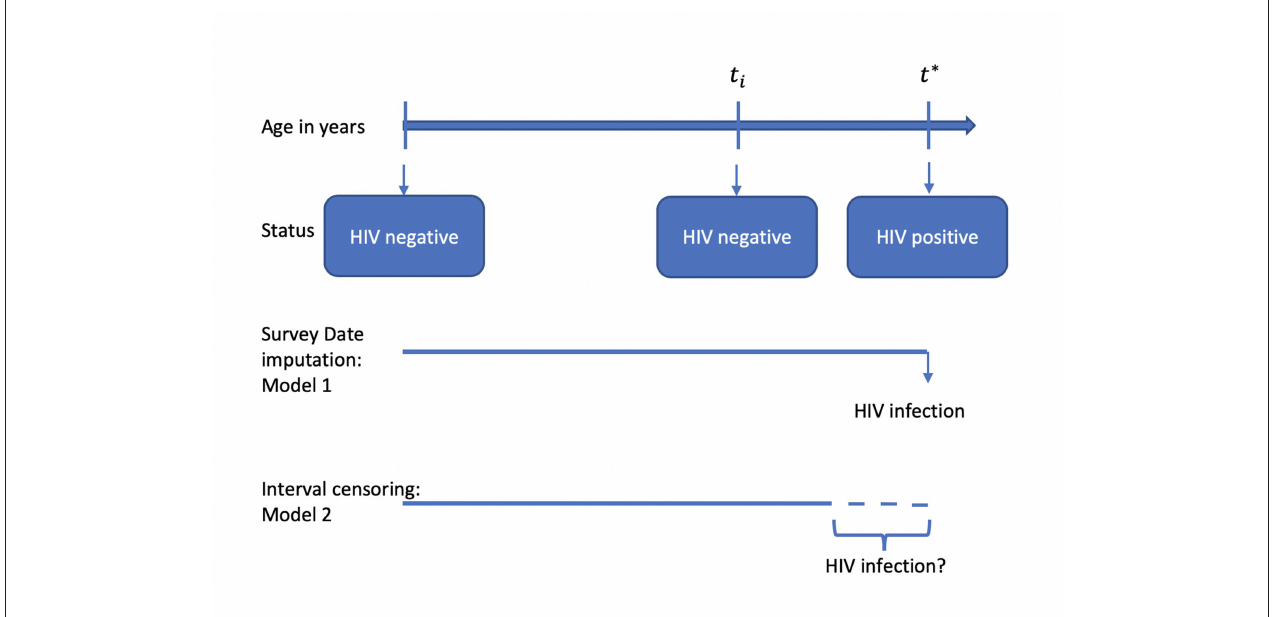
FIGURE 1 | Illustration of different modeling strategies when investigating the factors associated with HIV